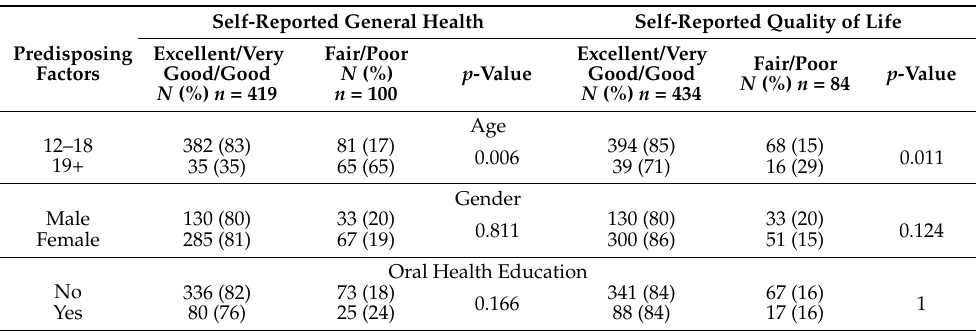
Table 3. Frequency distribution of the Andersen and Newman (A&N) predisposing and enabling factors between self-reported general health and self-reported quality of